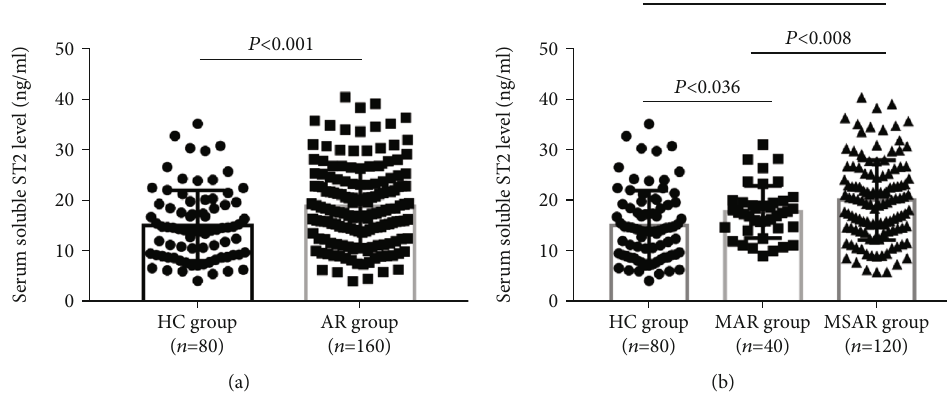
Figure 1: Serum sST2 concentrations were increased in AR patients than in healthy controls. (a) sST2 levels were elevated in the AR group in comparison with the HC group; (b) the serum sST2 levels were higher in the MSAR group than in the MAR and the HC group. sST2: soluble suppressor of tumorigenicity 2; AR: allergic rhinitis; HC: healthy control; MAR: mild allergic rhinitis; MSAR: moderate-severe allergic rhinitis.